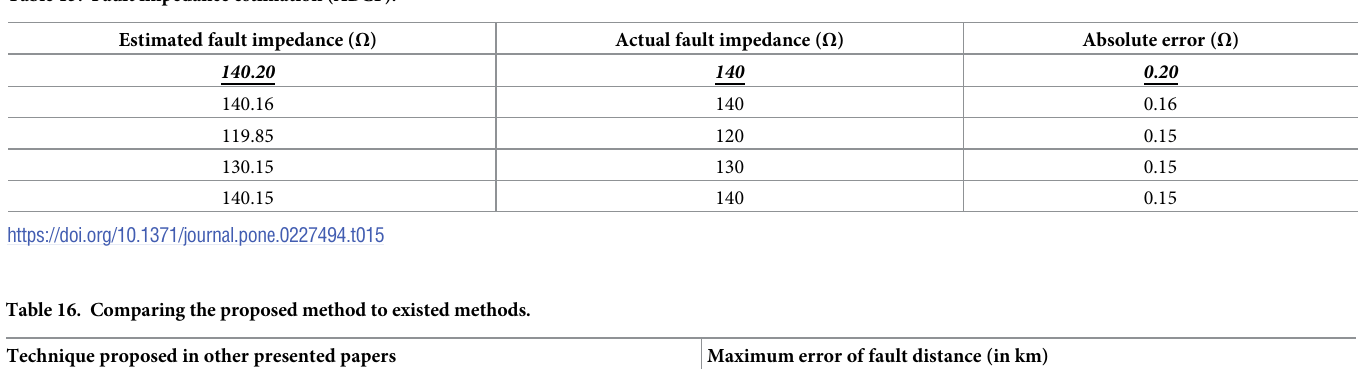
Table 15. Fault impedance estimation (ABCF).